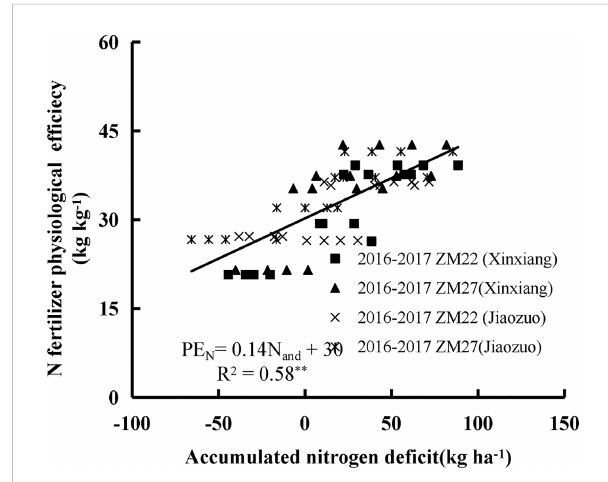
FIGURE 6 The relationship between accumulated N de fi cit and N fertilizer physiological ef fi ciency of winter wheat from 2016 to 2017 at Xinxiang and Jiaozuo. The symbol **indicates that the p -value is<0.01.